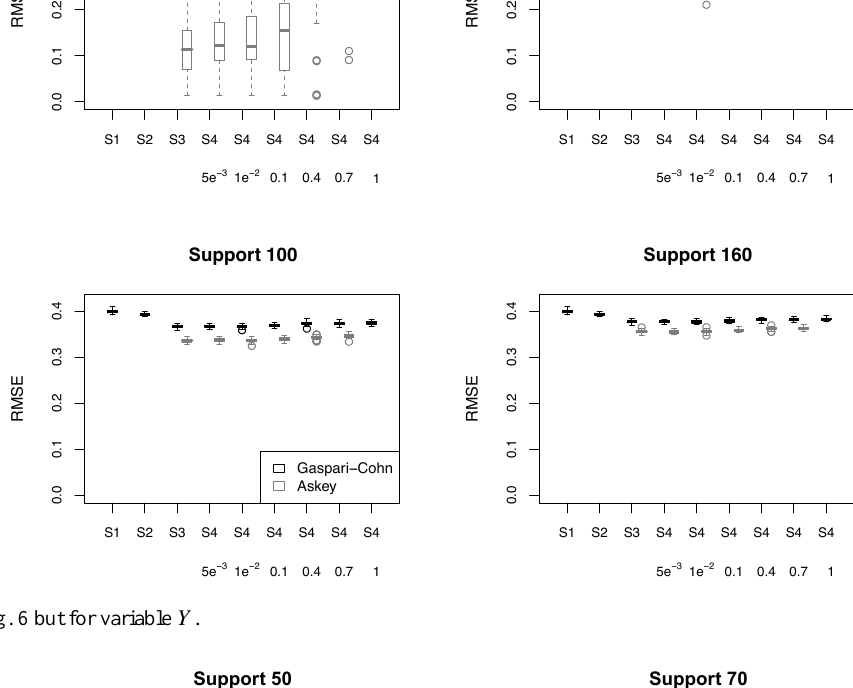
Figure 7. Same as Fig. 6 but for variable Y .